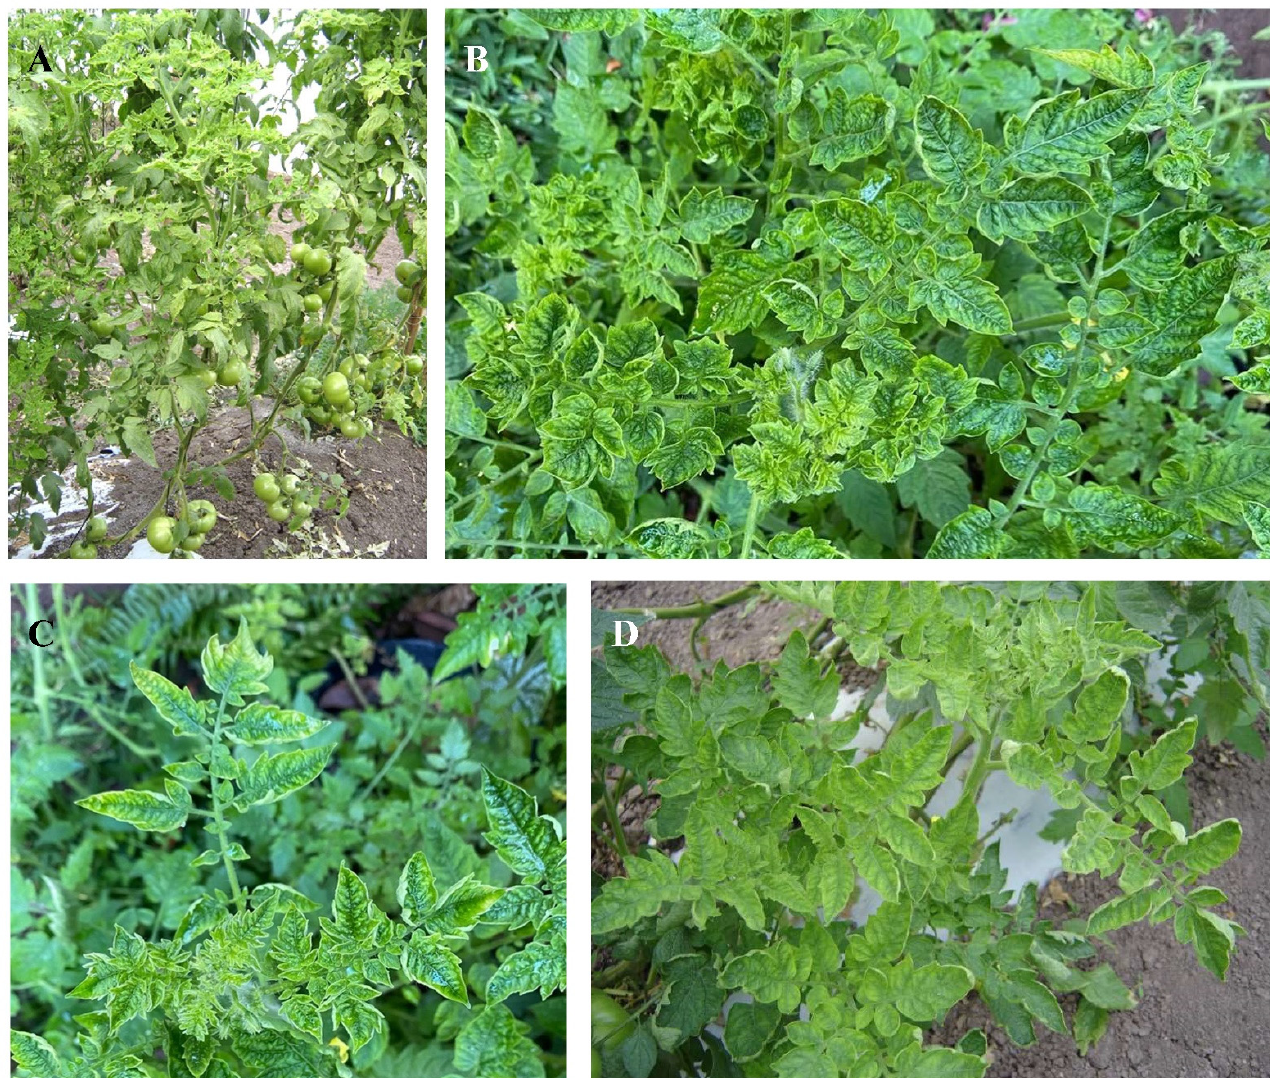
Figure 3. Symptoms caused by tomato yellow leaf curl virus on tomato plants. ( A ) Infected plants showing growth delay as well as yellowing and curling of the leaflet margins (spooning). ( B – D ) Leaflets of tomato leaves with curling and yellowing.